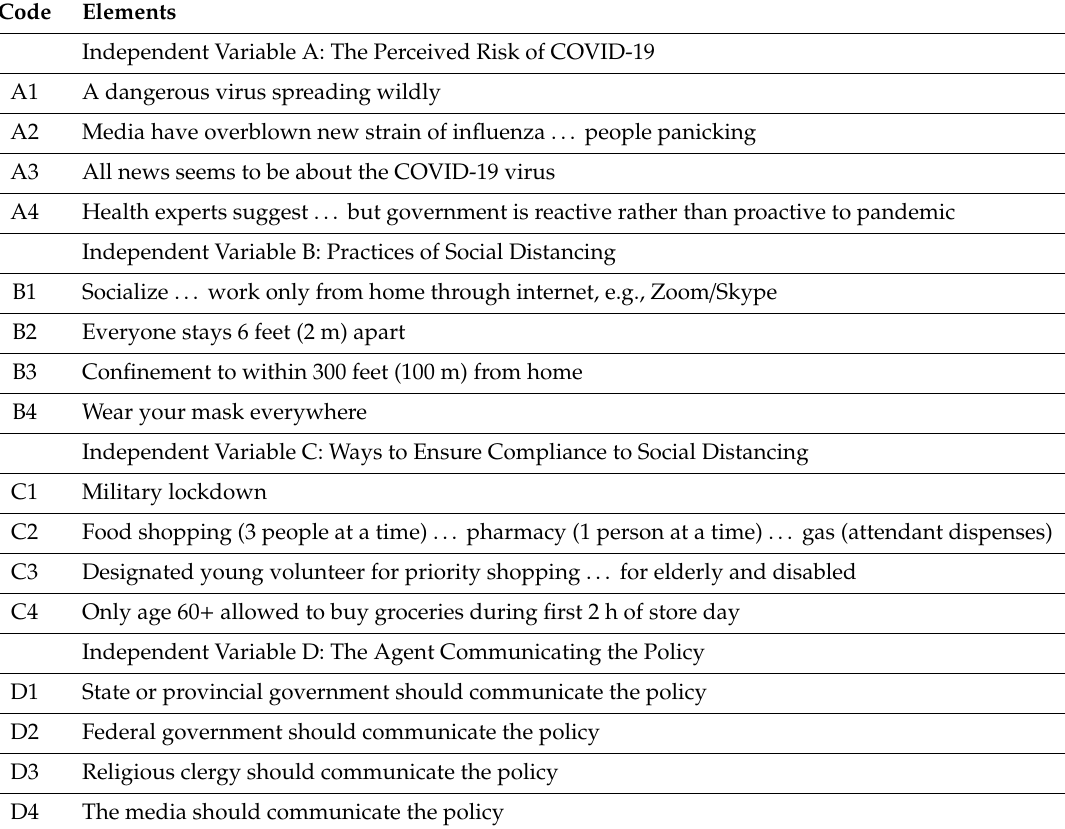
Table 2. The four independent variable categories, and the four test messages to be incorporated into the